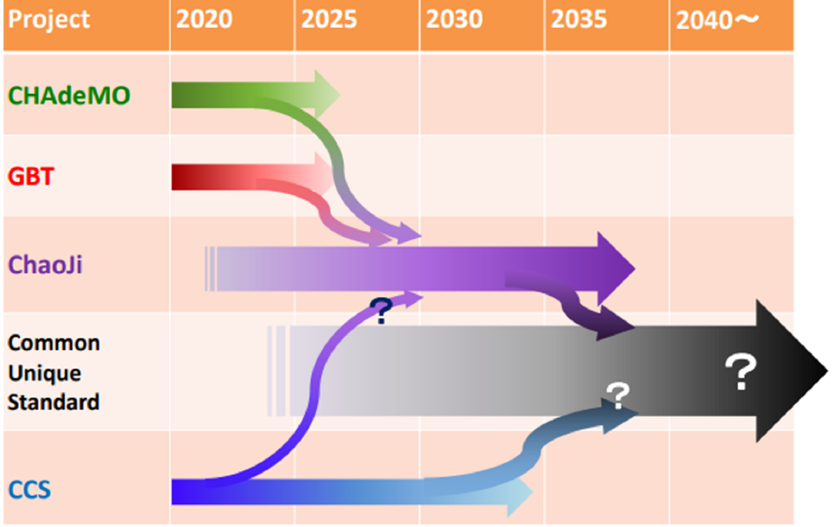
Figure 26. ChaoJi towards harmonization.